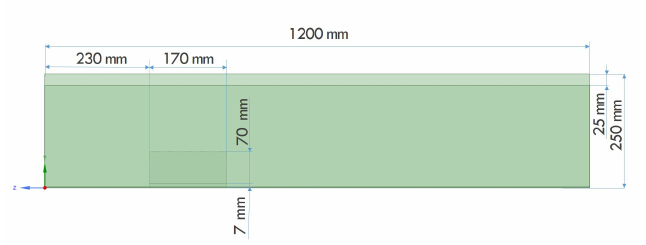
Figure 4. Domain dimensions in side view.